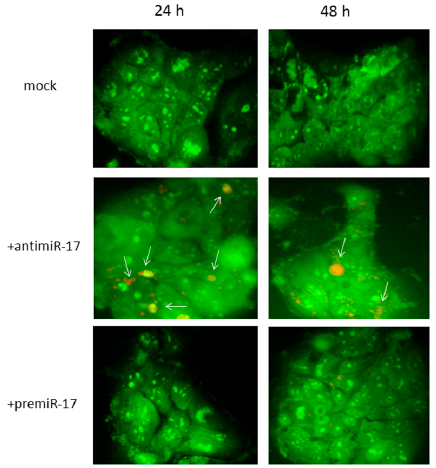
Figure 9. Fluorescent evaluation of autophagy vesicles in Caco-2 cells after differential exosome uptake. Exosomes isolated from T98G cells were electroporated with antimiR-17 or premiR-17 molecules (2.5 µM each) and administered or not (mock) to growing Caco-2 cells. After 24–48 h post-administration, cells were then incubated with acridine orange dye (200 µg/mL, for 5 min at 37 °C) and then visualized by inverted fluorescent microscope evaluation (40× magnification). Arrows indicate large acidic vesicles, likely autophagosomes.